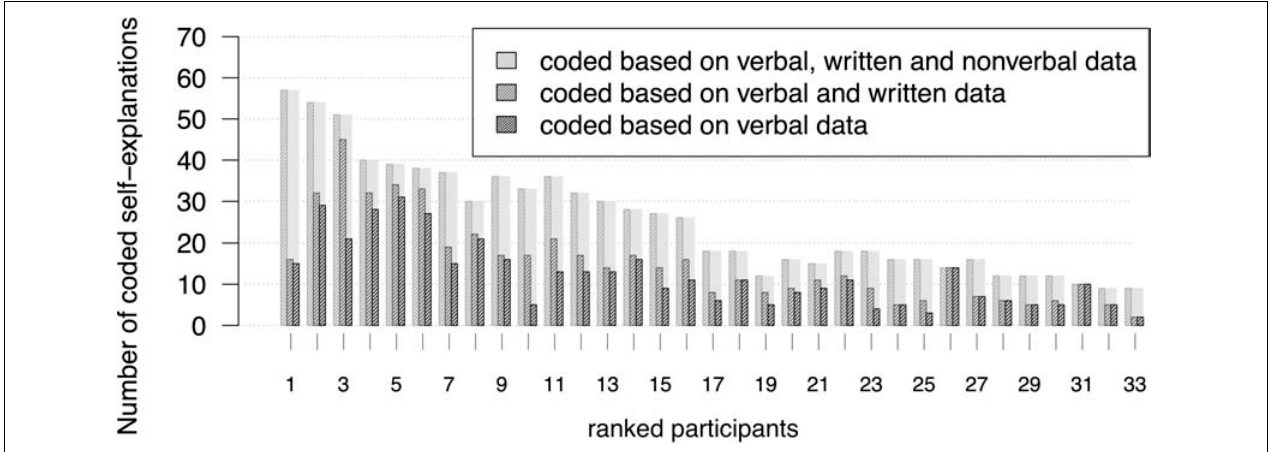
FIGURE 9 | Data used to code adequate self-explanations. The subjects are ordered according to the number of self-explanations coded based on verbal, written, and non-verbal data (same order as in Figure 4